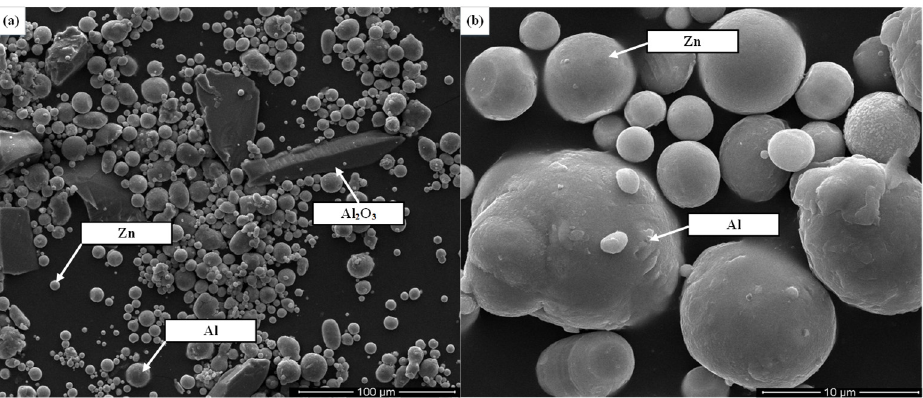
Figure 1. The powder morphology from SEM: ( a ) 500× ( b ) 2000×.